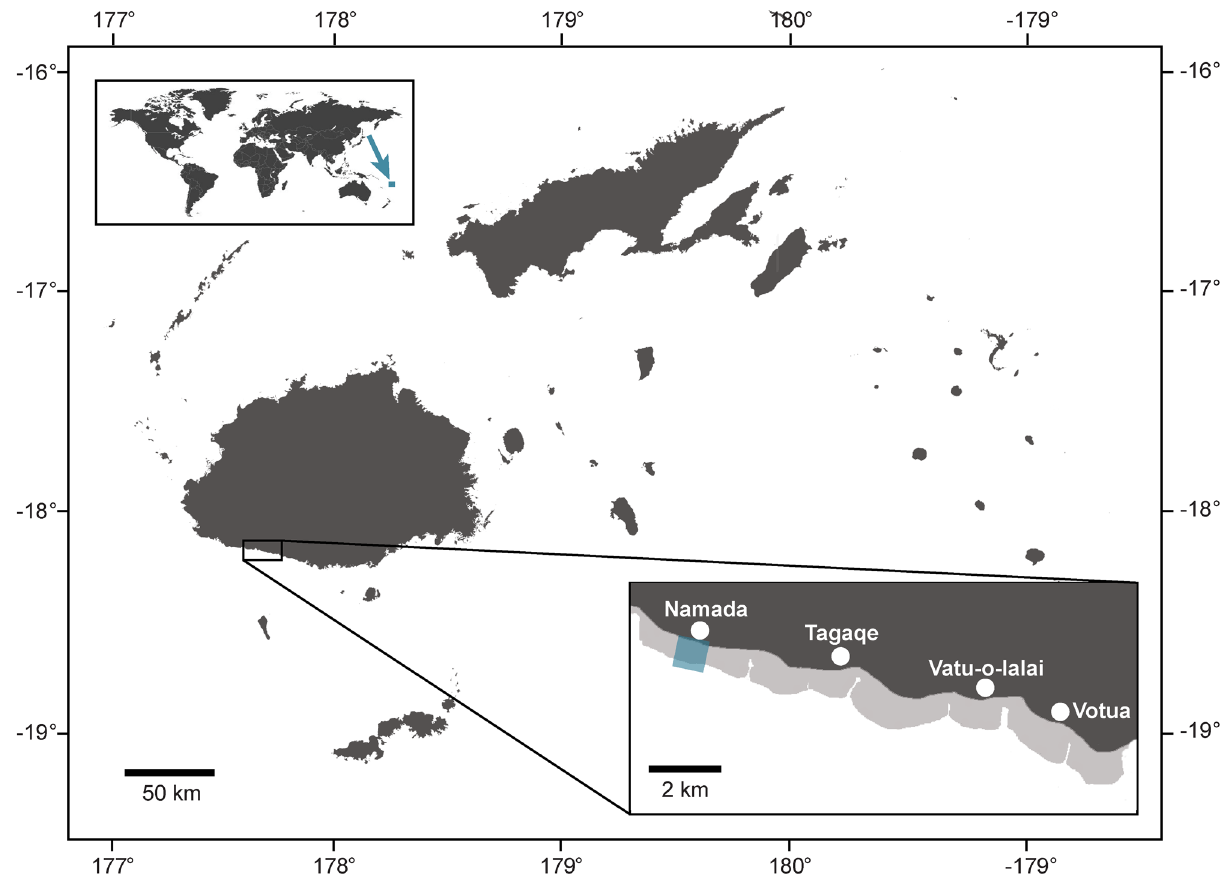
Figure 6. Map of Fiji, with study site (Namada no-take area) marked by blue rectangle. This figure was created using QGIS 3.4.9 (http:// www. qgis.